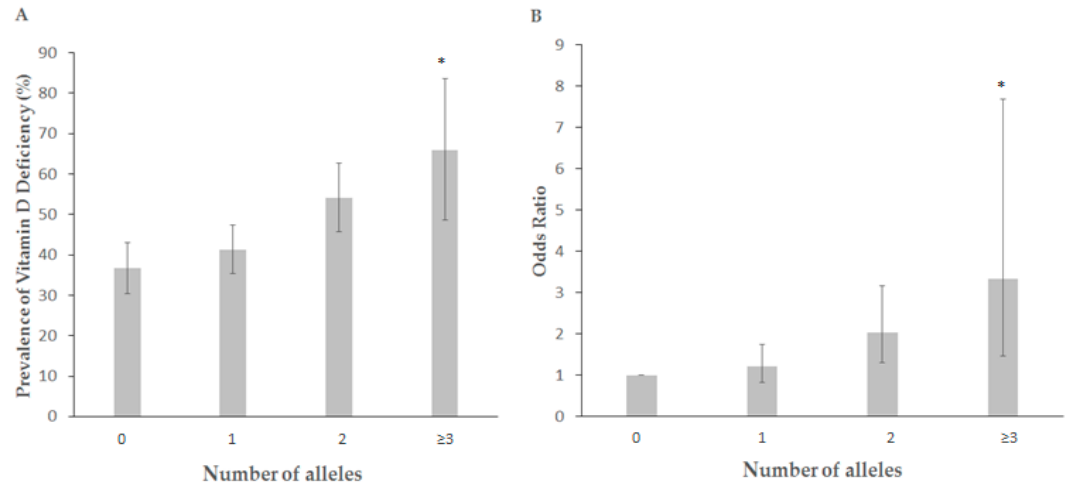
Figure 1. Dose-response relationship between the number of risk alleles in rs4516035, rs2282679 and vitamin D deficiency. * Lines indicate 95% confidence intervals. ( A ) Prevalence of vitamin D deficiency status by GRS. ( B ) Odds Ratio of vitamin D deficiency status by GRS.